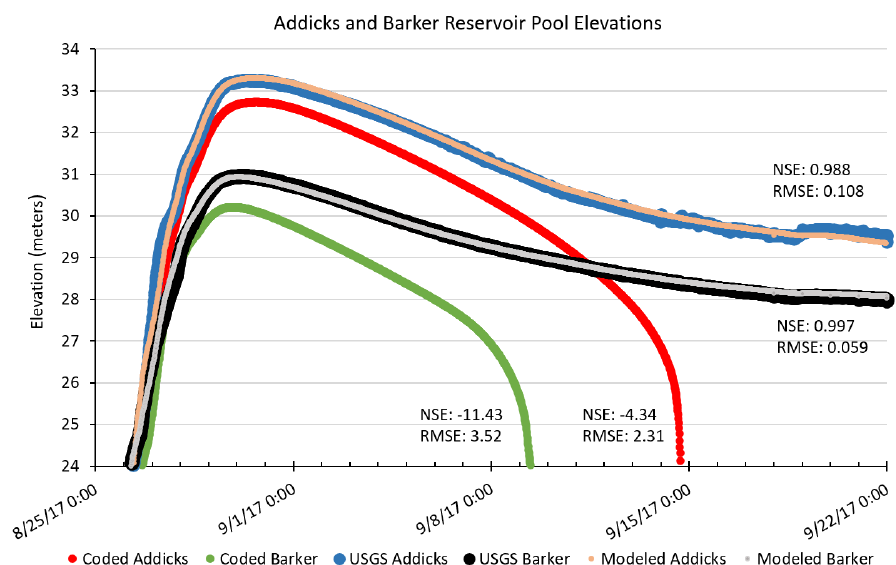
Figure 4. Addicks and Barker reservoirs pool elevation during Hurricane Harvey.